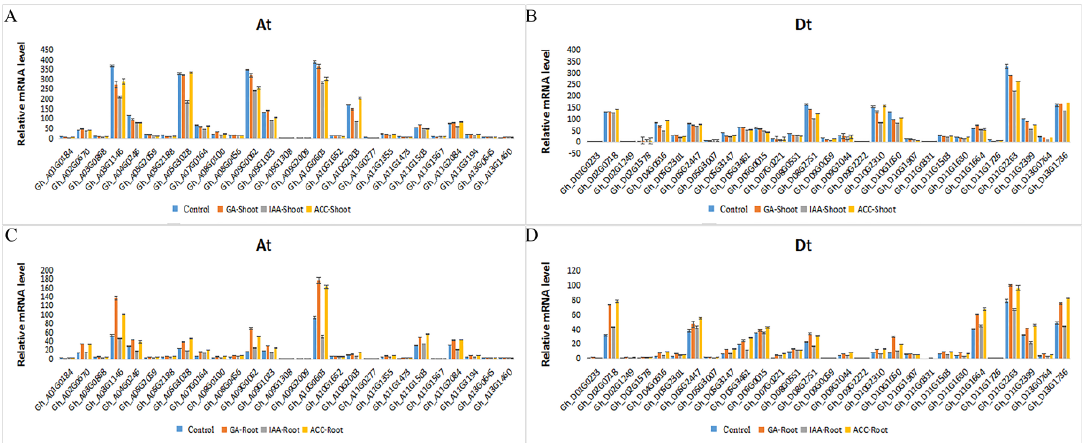
Figure 6. Expression of GhRCC1 genes in seedlings following hormone treatment. ( A ) Expression profiles of GhRCC1 At family genes and ( B ) Dt family genes in shoots treated with 50 mM IAA (indole-3-acetic acid), 5 mM GA (gibberellic acid), or 50 mM ACC (1-aminocyclopropane-1-carboxylic acid) for 3 h, respectively. ( C ) Expression profiles of GhRCC1 At family genes and ( D ) Dt family genes in roots treated with 50 mM IAA, 5 mM GA, or 50 mM ACC for 3 h, respectively. Error bars represent standard deviations from three biological replicates.